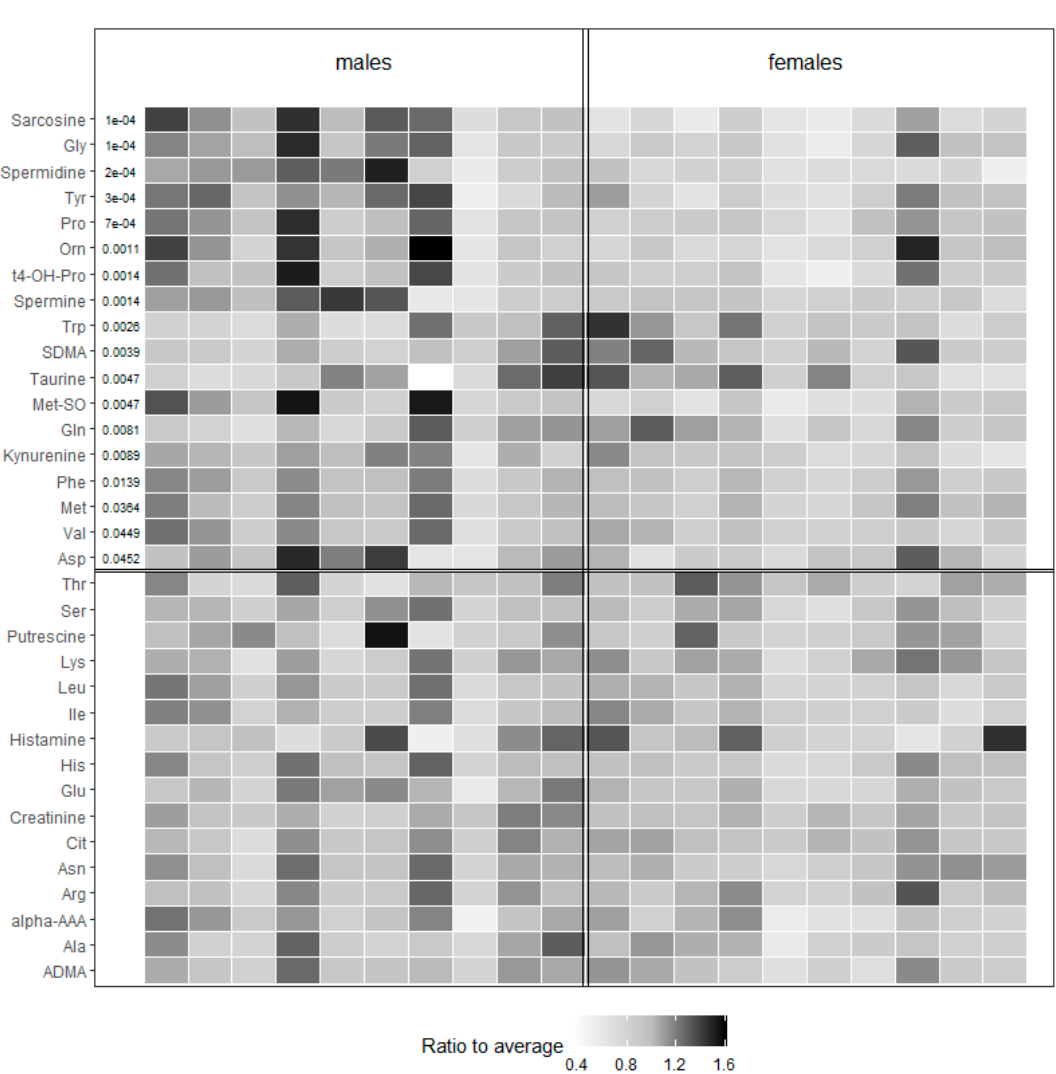
Figure 2. Heat map representing the values of amino acids and biogenic amines of tested male and female animals. Values of each metabolite are color-coded and represent a ratio to average. p values indicate the significance and are listed in the beginning of the corresponding line. The lines without p values are nonsignificant. Val (Valine), Tyr (Tyrosine), Trp (Tryptophan), Thr (Threonine), t4-OH-Pro ( trans -4-hydroxyproline), Ser (Serine), SDMA (Symmetric dimethylarginine), Pro (Proline), Phe (Phenylalanine), Orn (Ornithine), Met-So (Methionine-Sulfoxide), Met (Methionine), Lys (Lysine), Leu (Leucine), Ile (Isoleucine), His (Histidine), Gly (Glycine), Glu (Glutamate), Gln (Glutamine), Cit (Citrulline), Asp (Aspartate), Asn (Asparagine), Arg (Arginine), Alpha-AAA (alpha-aminoadipic acid), Ala (Alanine), and ADMA (Asymmetric dimethylarginine).